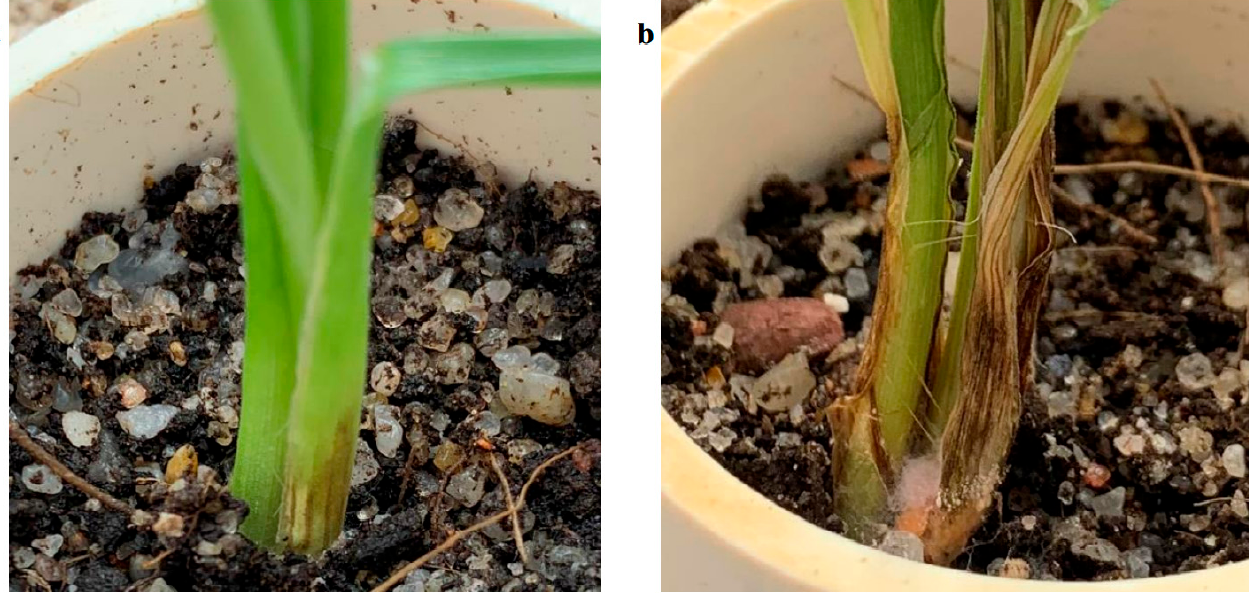
Figure 6. Infected plants on 14 DAI and 21 DAI. These images compare the brown discoloration symptoms of infection wheat between 14 DAI ( a ) and 21 DAI ( b ).